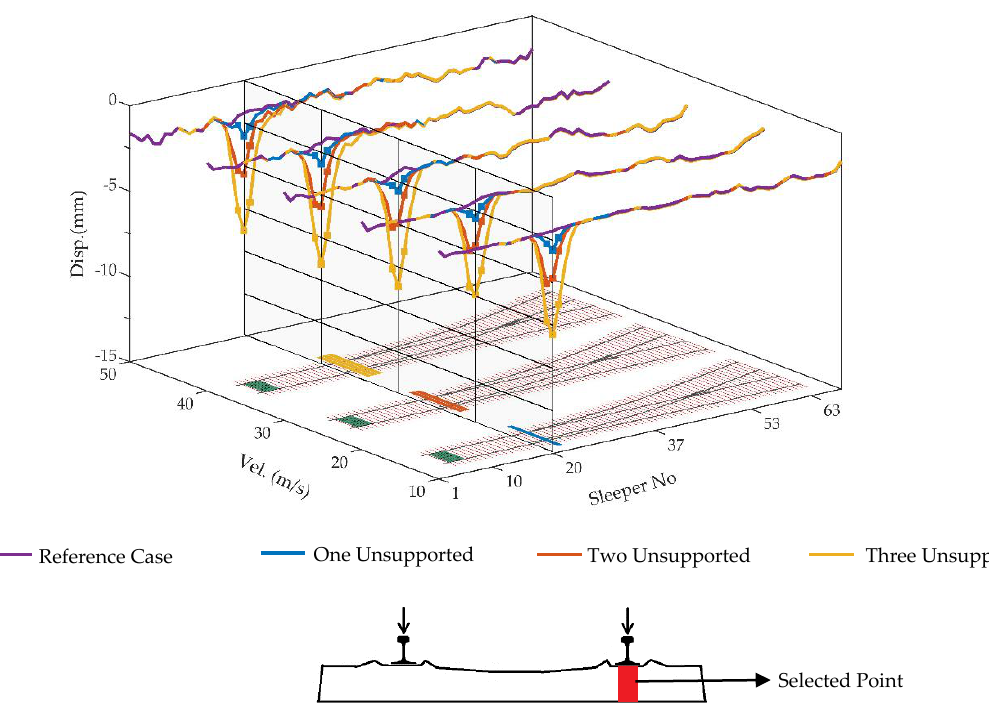
Figure 5. The maximum displacement of bearers at rail seats when an unsupported bearer exists under switch blade.